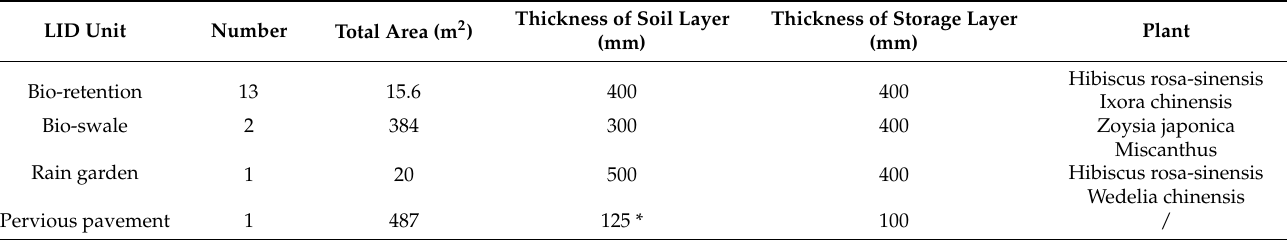
Table 1. A brief introduction of LID units in the study